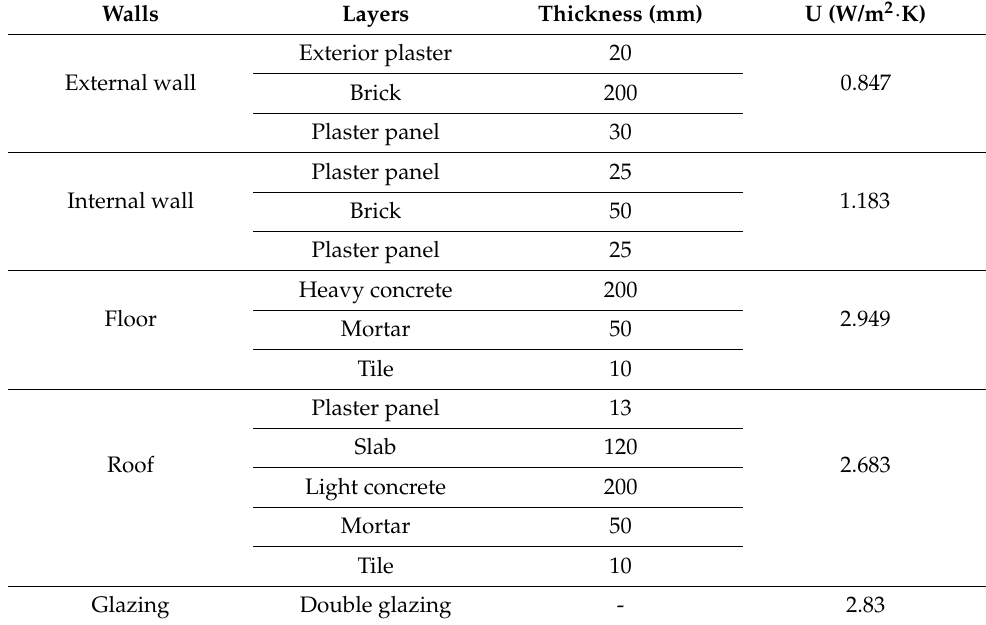
Table 5. Building envelope action on the